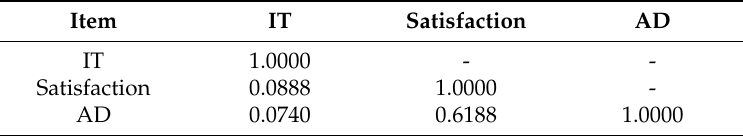
Table 6. Spearman correlations ( n =